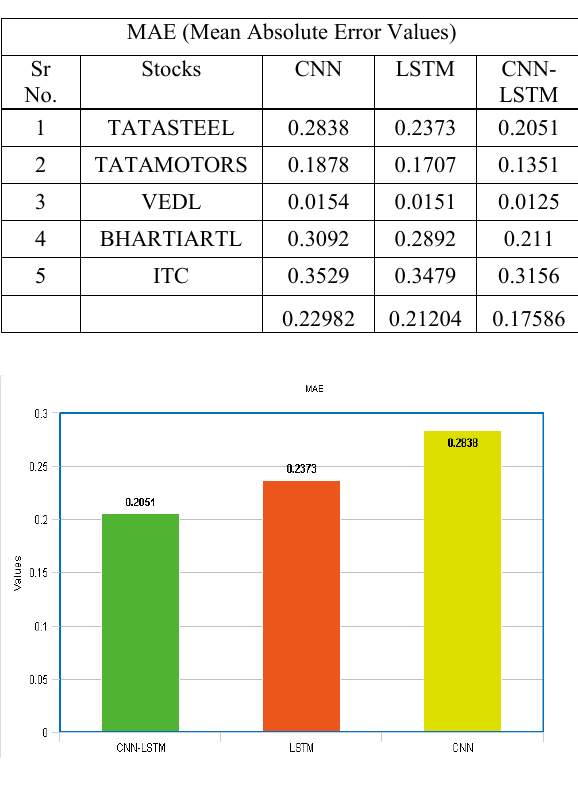
Figure 11. MAE comparison on TATSTEEL